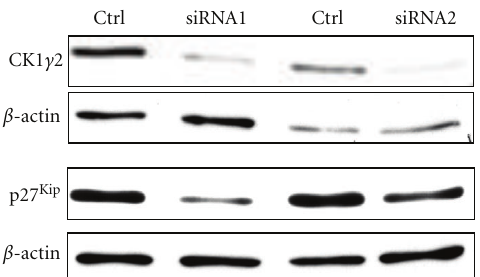
Figure 10: Downregulation of CKI γ 2 in HepG2 cells decreases expression of p27 Kip1 . HepG2 cells were transiently transfected with control or hCKI γ 2 (R1, R2) siRNA. Forth eight hours after transfection, cell lysates normalized for protein content were subjected to Western Blot analysis with indicated